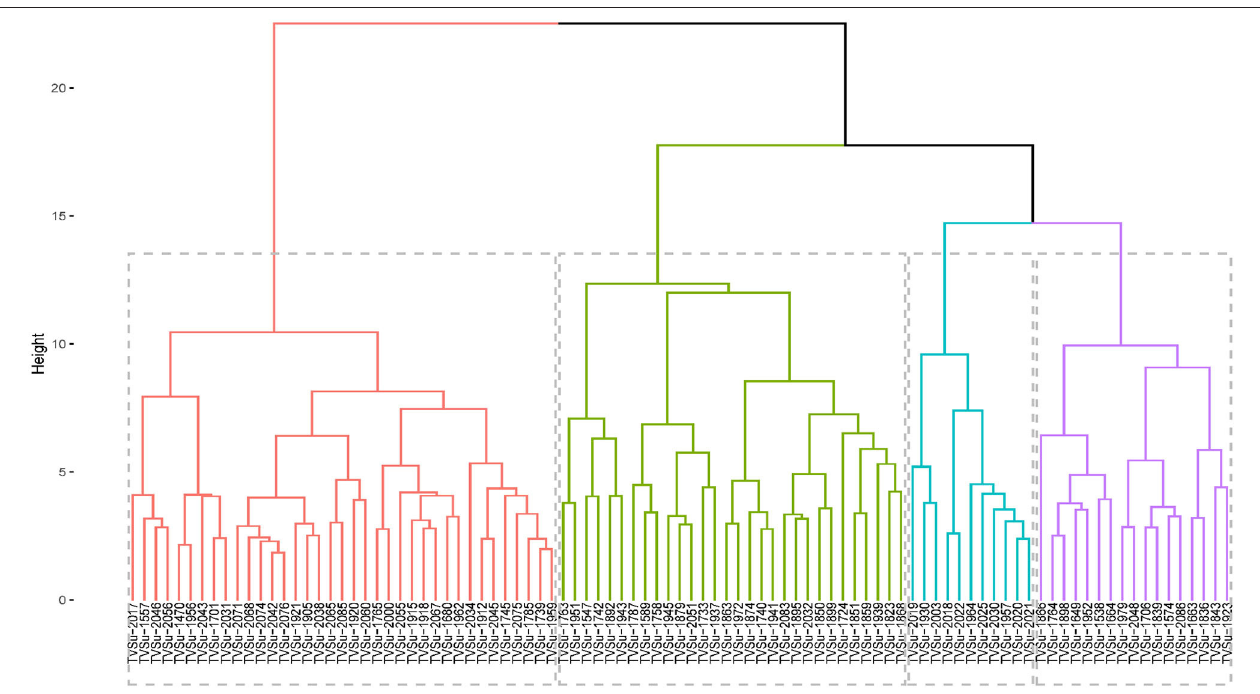
FIGURE 3 | Hierarchical clustering dendrogram analysis; Euclidean distance was used and the associations between groups were done by the Ward method for morphological traits across the